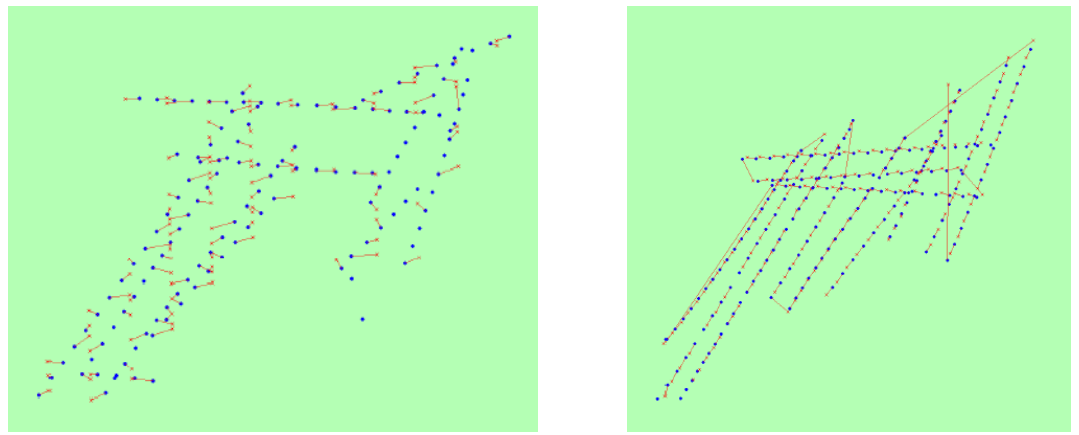
Figure 1: Image positions for the flights with the visible (left) and NIR sensor (right) for the dataset in Figure 3 (right). In blue one can see the refined camera centers as computed from the software described in secion 3.1. Red lines connect those camer centres to the original GPS positions. These datasets show that the GPS measurements of the UAV are of low accuracy, contain missing GPS positions for some images (left figure) and could potentially be mistagged or shifted (right